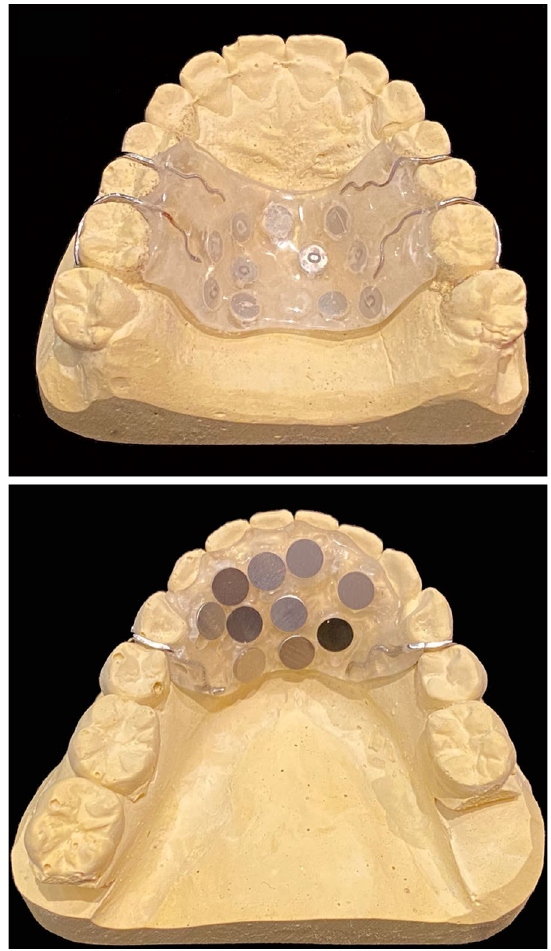
Fig. 3 Splints for maxilla and mandible to collect in vivo-grown